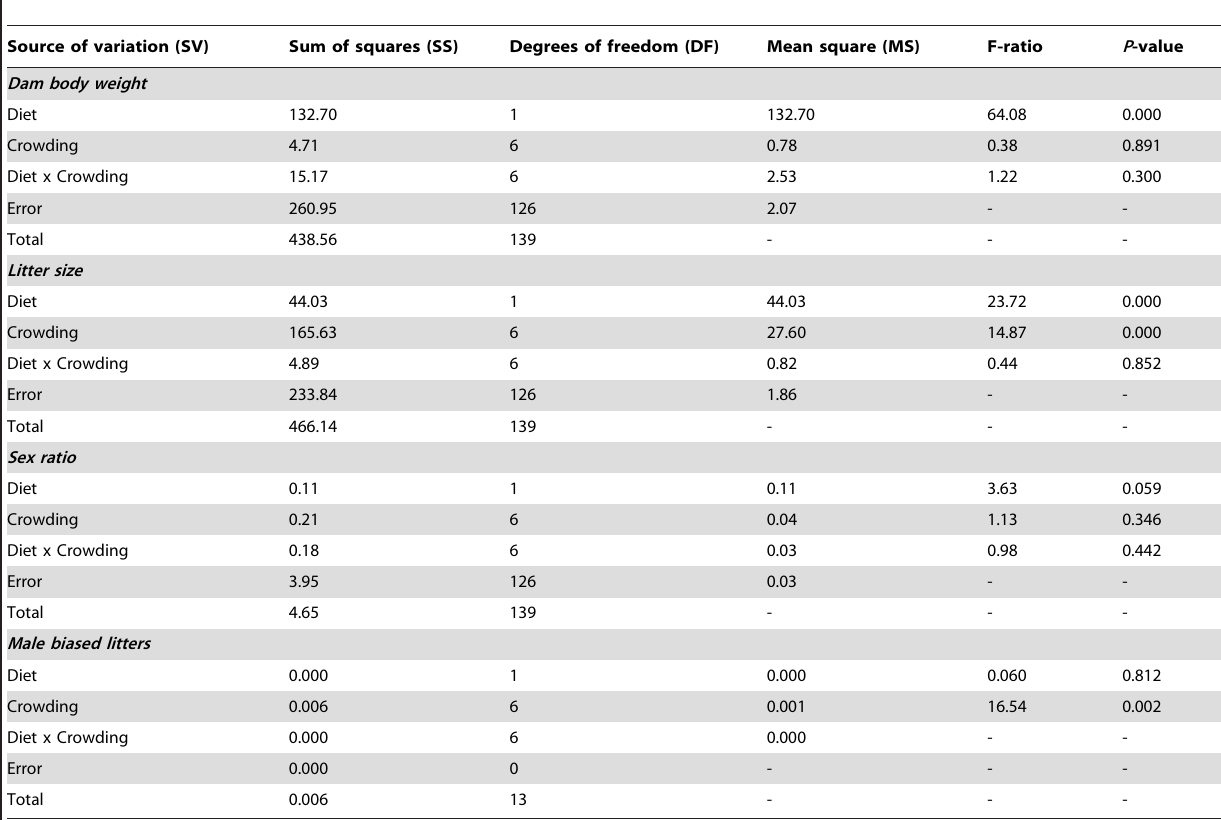
Table 2. Analysis of variance summary for dam body weight, litter size, sex ratio and proportion of male biased litters from NFD and HFD